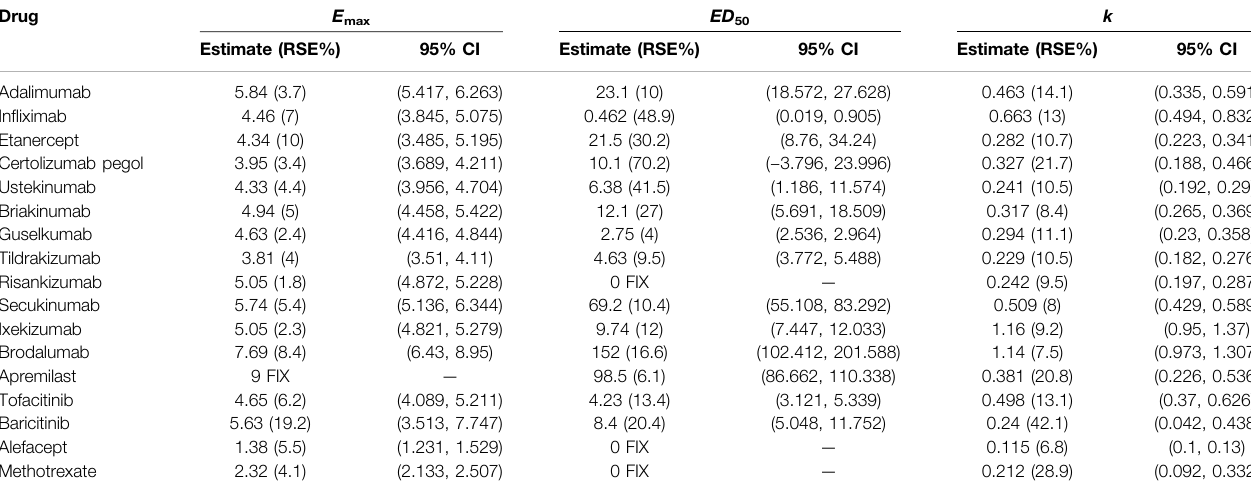
TABLE 2 | Final parameter estimates of PASI75 longitudinal model.